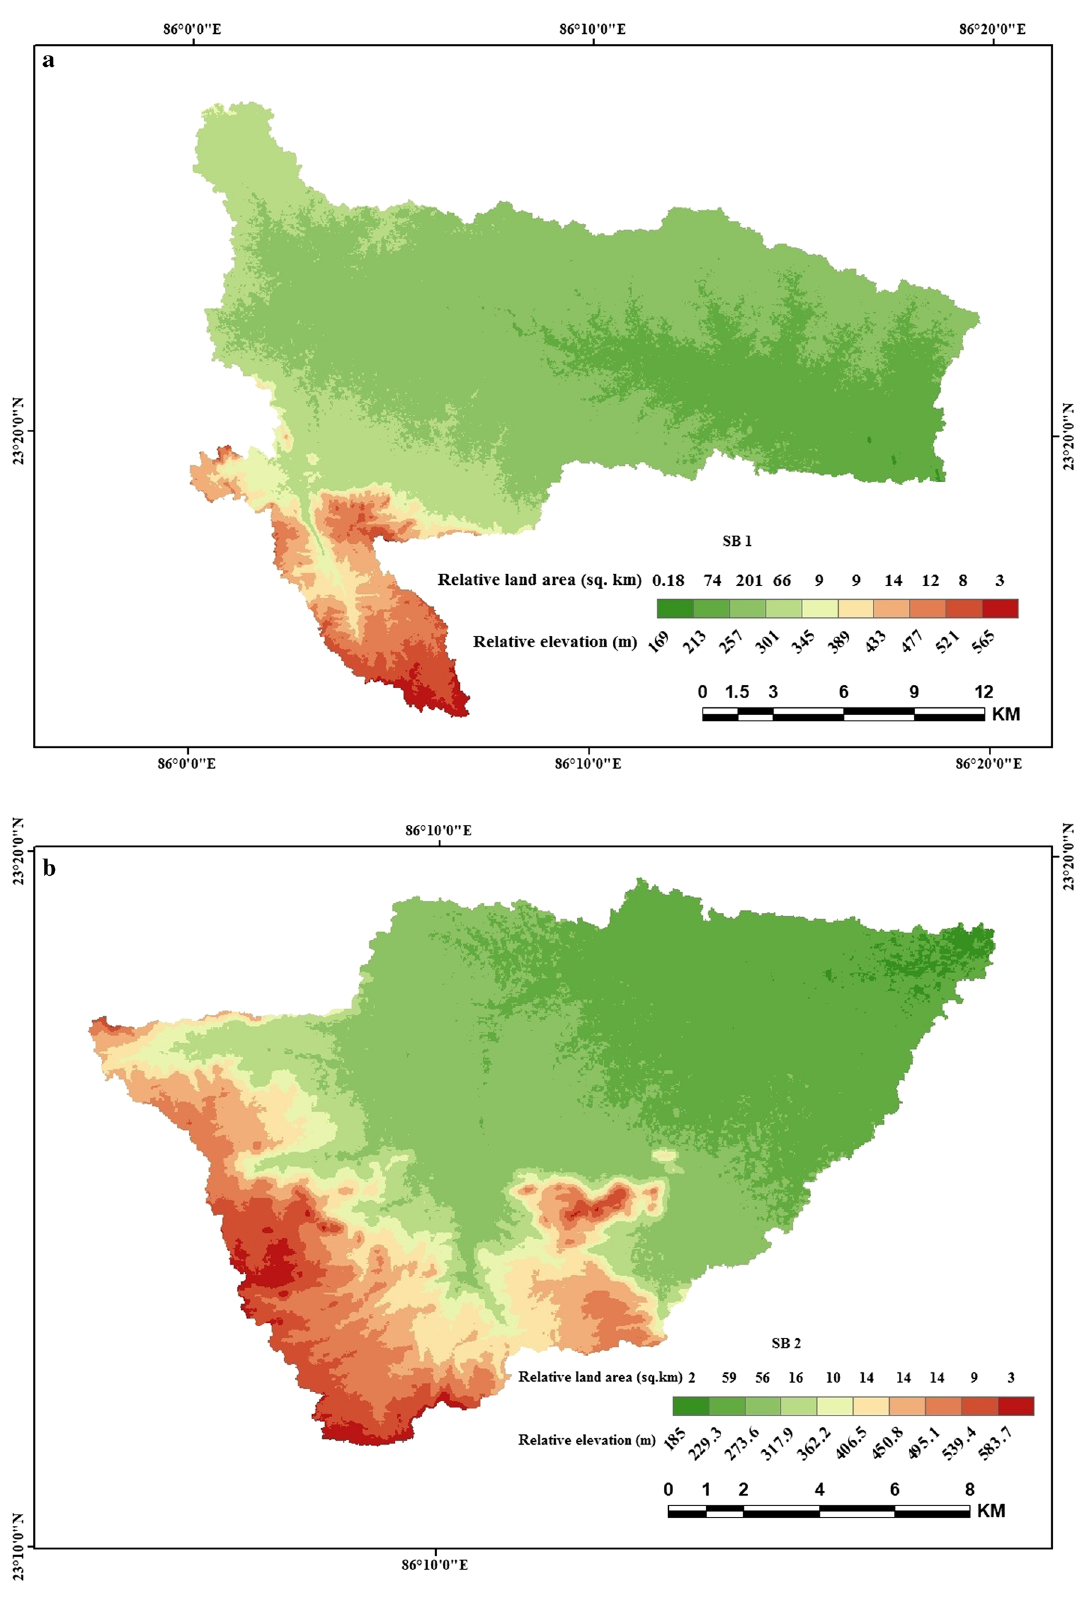
Fig. 10 a – m Sub-basin-wise hypsometric analysis of relative land area distribution based on ten class relative